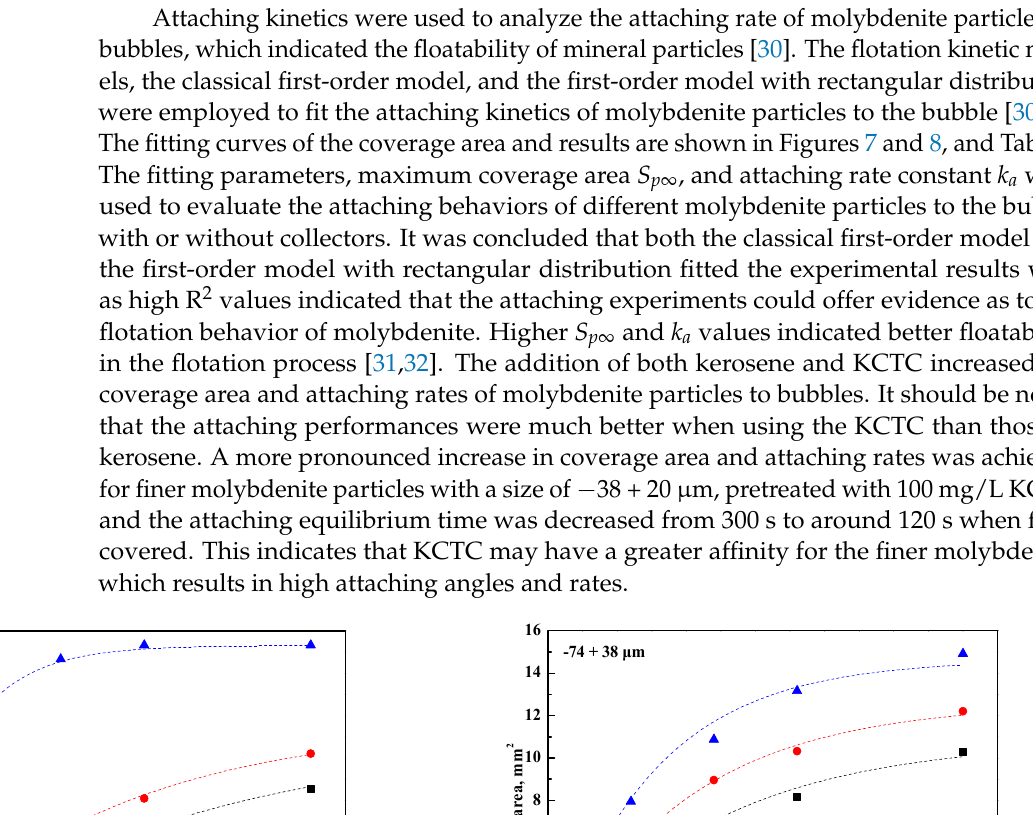
Figure 6. Surface coverage of bubbles with different molybdenite powders, as the function of different collectors.